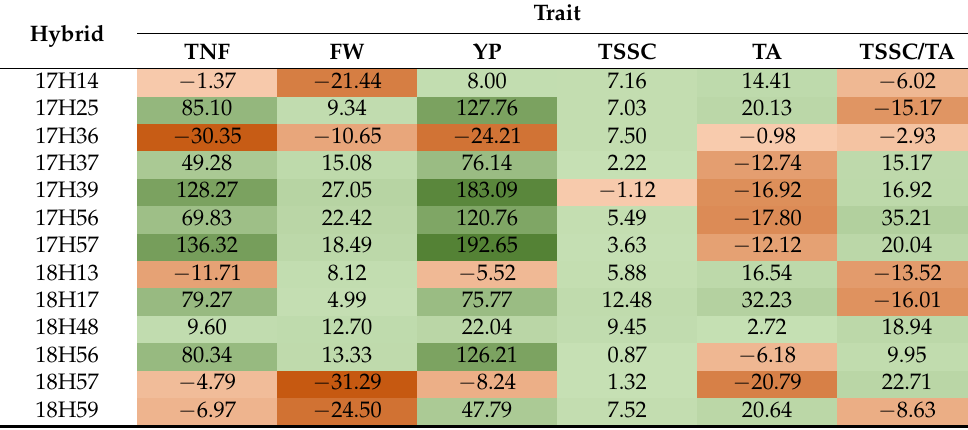
Table 3. Heterosis percentage (Het%) of six phenotypic traits in 13 F 1 hybrids. TNF, number of fruit per plant, FW, fruit weight, YP, yield per plant, TSSC total soluble solid content, TA titratable acidity, TSSC/TA total soluble solid content/titratable acidity ratio. The green and brown colours and their shades represent the lower and the higherpositive and negative heterotic levels, respectively. Hybrid